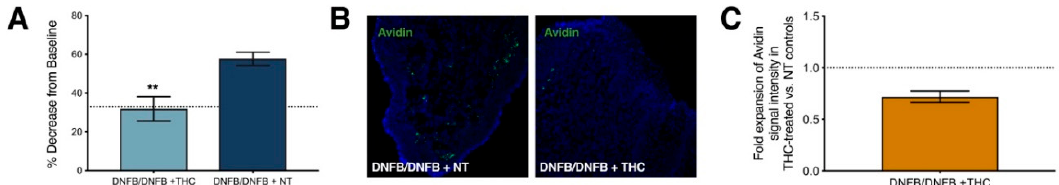
Figure 4. Repeated local ∆ 9 -tetrahydrocannabinol (THC) application after ten DNFB challenges in the vaginal canal results in decreased sensitivity and local mast cell densities compared to controls. ( A ) Sensitivity measured 1 day after 10 DNFB challenges and either 6 THC treatments or no treatment (NT). Only post-treatment withdrawal responses that show a 33%, represented by the dotted line, or greater decrease from baseline withdrawal thresholds are considered hyperalgesic. ** represents a p -value of p < 0.01. n = 17–18; ( B ) Representative immunofluorescence images at 200x magnification showing fluorescent FITC-Avidin-stained mast cell granules in vaginal canals of THC treated and not treated mice; ( C ) Relative intensity of Avidin-stained mast cell granules in vaginal canals of THC treated mice calculated as fold change over non-THC treated mice. n = 3.